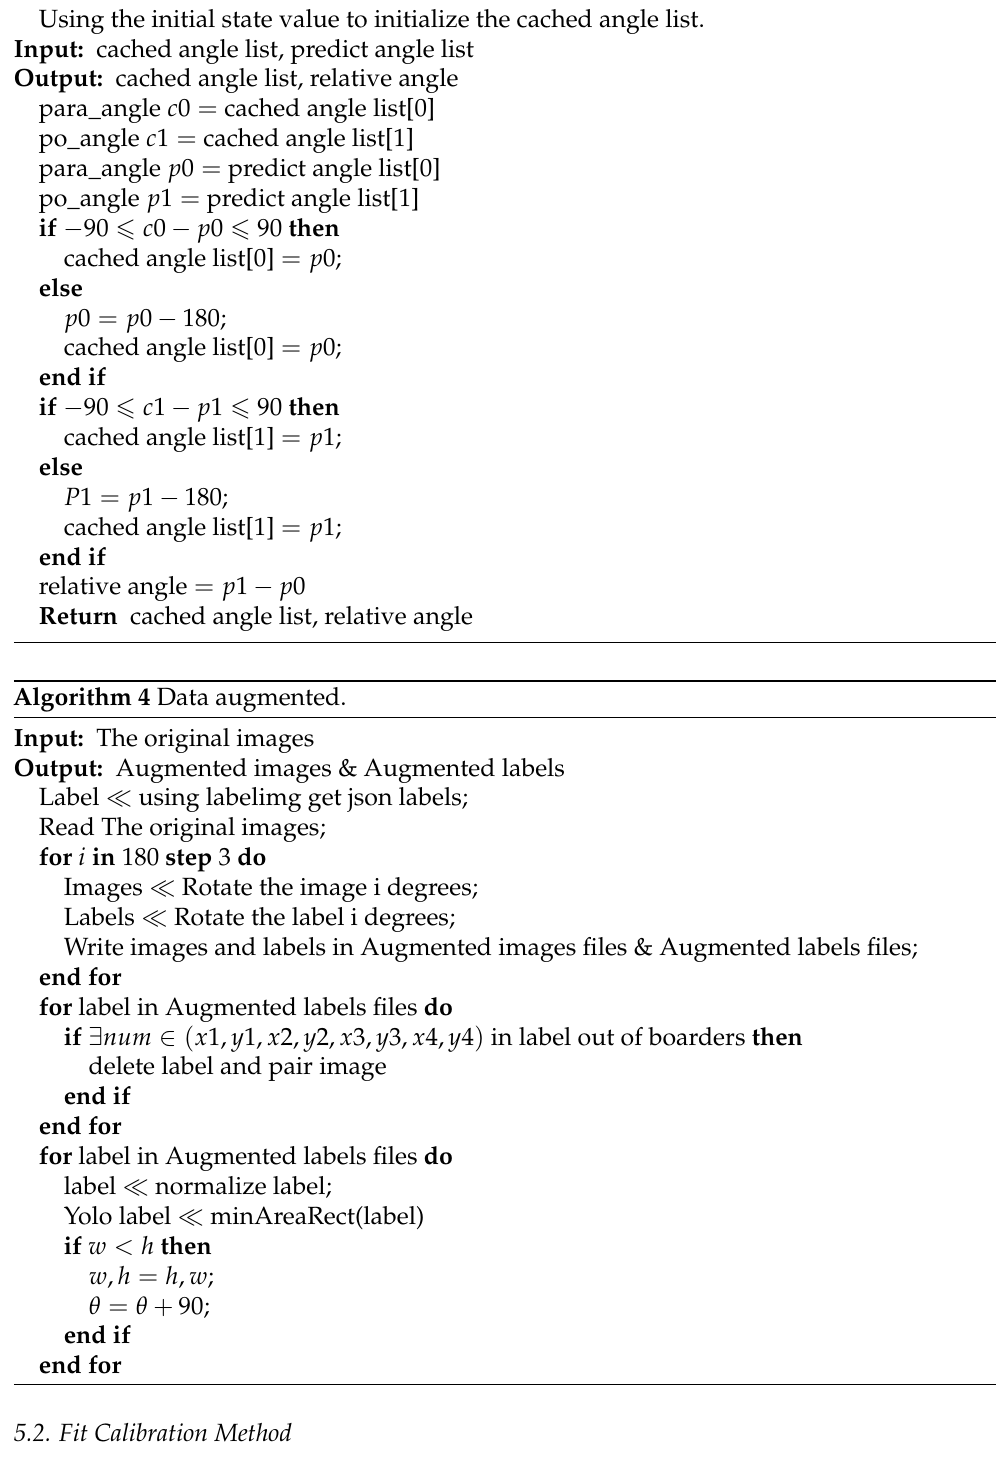
Algorithm 3 Angle transform.